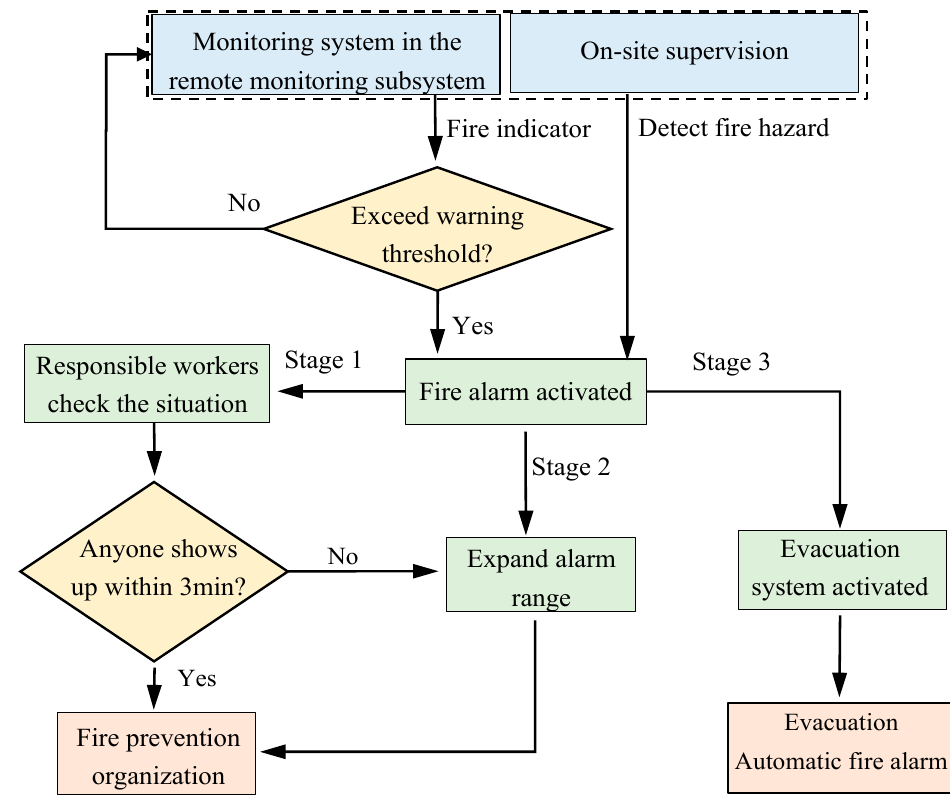
9 of 21 Table 1. Fire stages in the multi-stage fire alarm subsystem. Stages